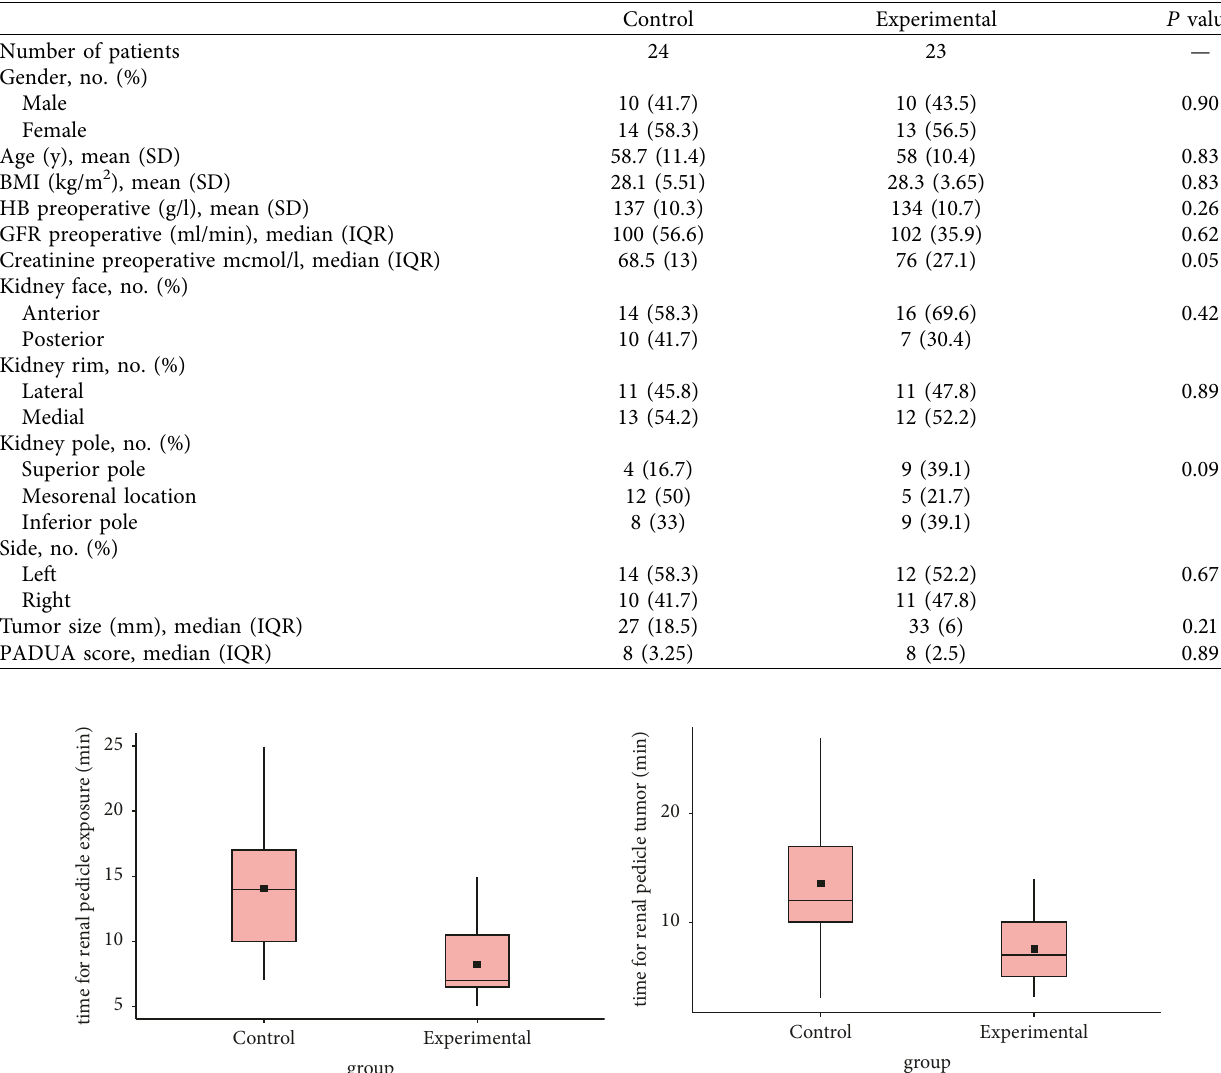
Table 1: Descriptive analysis of preoperative features.